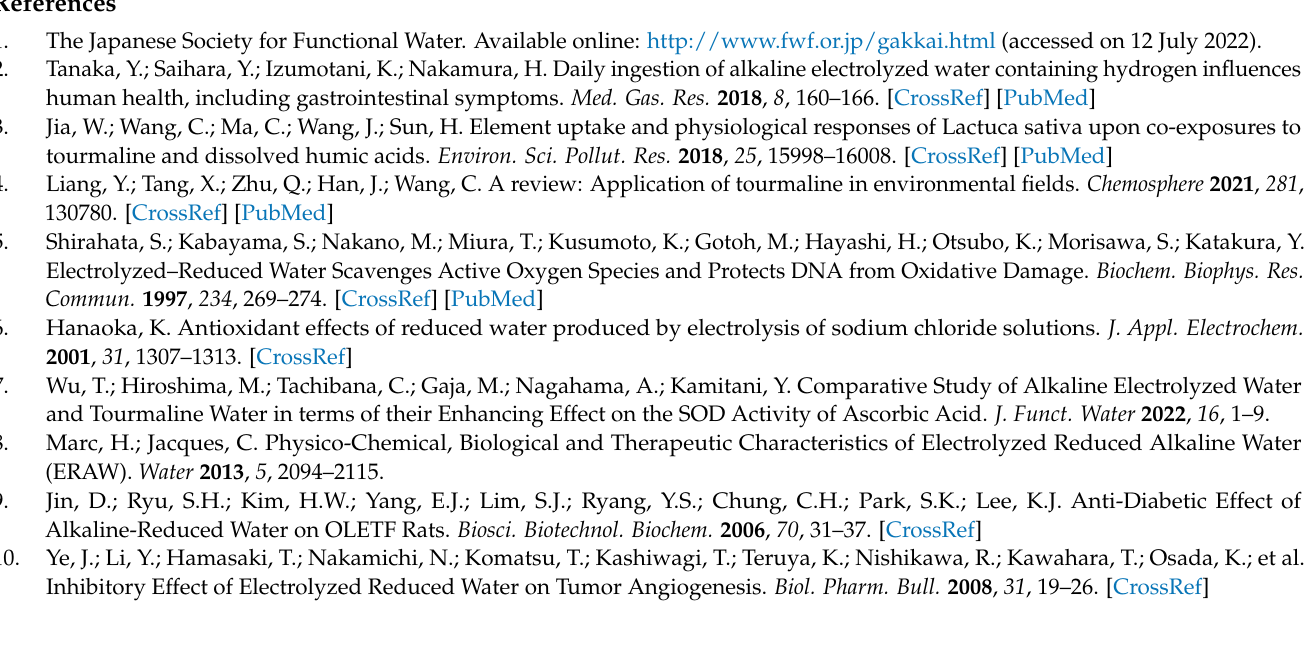
Figure S2: The relationship between volume of addition of sample water and the ◦ Brix of the (a-tropicana, b-freshly squeezed) concentrated reconstituted juice; Table S1: Sensory parameters scoring